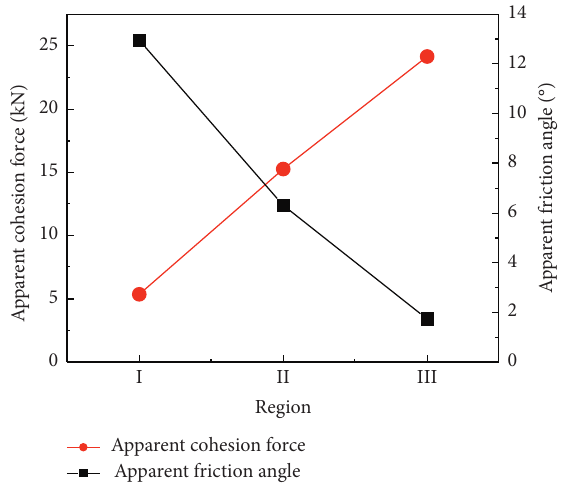
Figure 10: The variation laws of the shear strength parameters with three